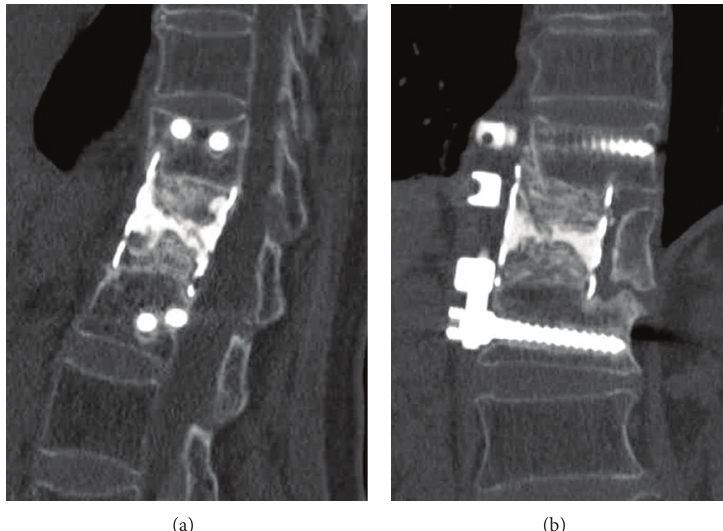
Figure 3: Computed tomography of the lumbar spine 2 years after surgery showing a bony fusion was successfully achieved without a recurrence of infection. (a) Sagittal view. (b) Coronal